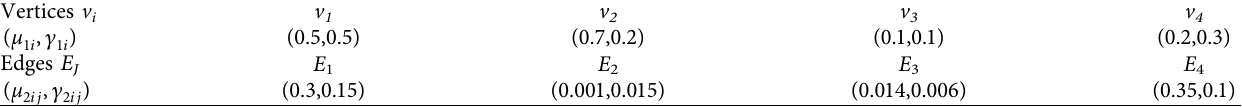
Table 9: Degree of membership and nonmembership values for vertices and edges of Figure